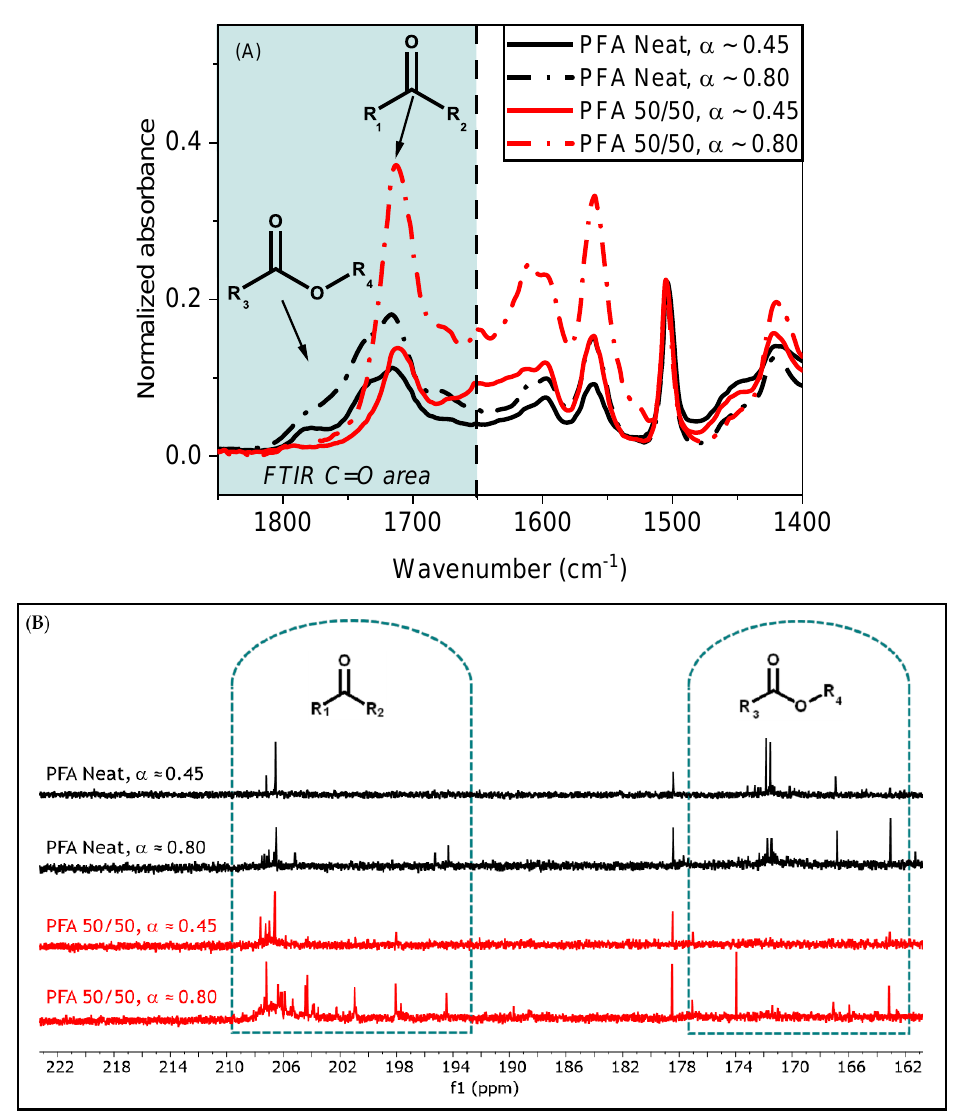
Figure 4. ( A ) Normalized FTIR spectra of PFA 50/50 water and neat PFA neat at α ≈ 0.5 and α ≈ 0.8. ( B ) 13 C NMR spectra of PFA 50/50 water and neat PFA at α ≈ 0.5 and α ≈ 0.8 with an accumulation of 6000 scans.